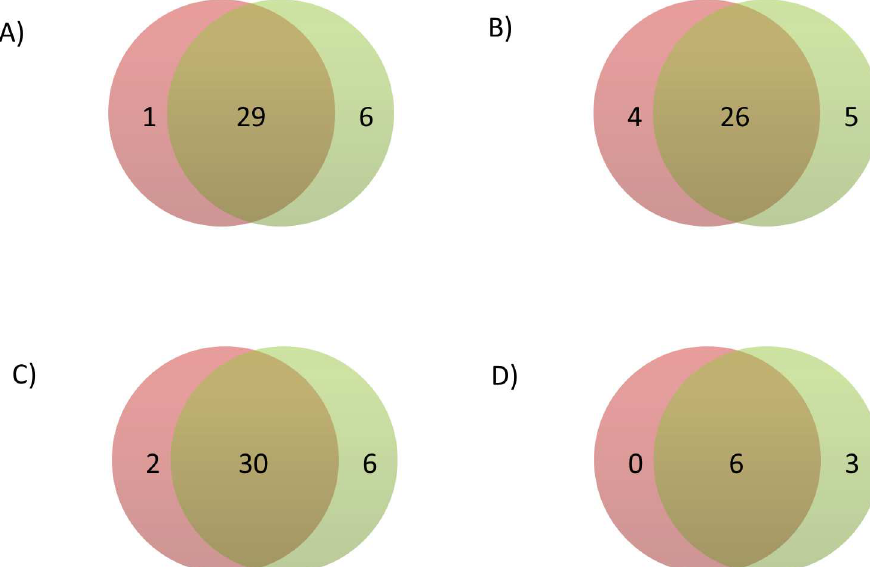
Fig 1. Venn diagram of the number of loci significantusing HapMap(left circle) and 1000G (right circle) imputationin A) the main analysis,B) the sensitivity analysisapplyinga significancethresholdof 2.5 × 10 − 8 to the 1000G GWA analysis, C) the sensitivity analysiswithout using genomiccontrol corrections, and D) the sensitivity analysisexcludingstudies that used different imputationsoftware, analysissoftware, or covariates in the HapMap and 1000G GWA